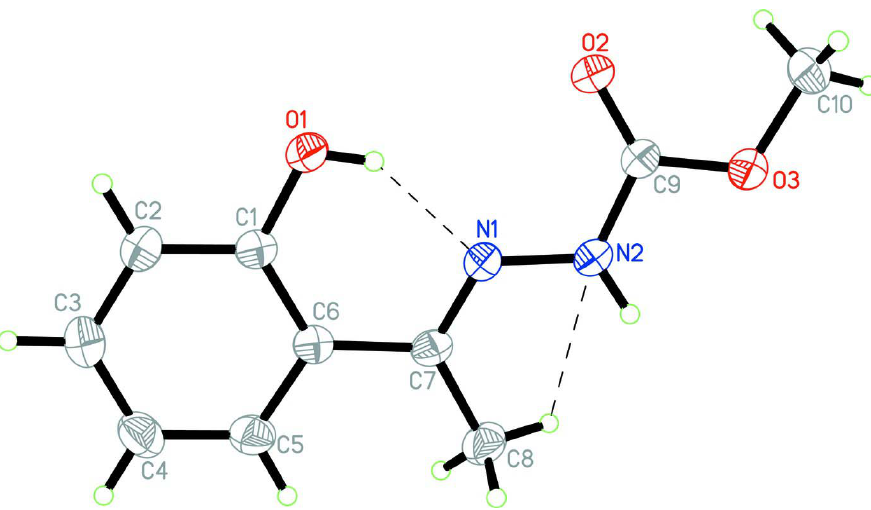
Figure 1 Molecular structure of the title compound, showing 30% probability displacement ellipsoids and the atomic numbering. Dashed lines indicate intramolecular hydrogen bonds.